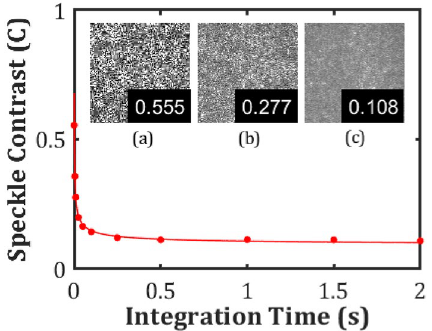
Figure 5. Speckle contrast measured after passing through a chiral nematic LC device (E7 + 4.7 wt% BDH1281, pitch 310 nm) under a square wave electric field of amplitude 13.6 Vµm −1 and a frequency of 75 Hz at a range of camera integration times. The cell thickness was d = 20 µm, cell temperature T = 25 °C. The data points were obtained from measurements and the solid red line is a fit of the form ax −0.5 + b which shows that C reduces approximately by 1 / √ τ . Inset speckle images shown for ( a ) 1 ms, C = 0.555, ( b ) 10 ms, C = 0.277, ( c ) 2 s, C = 0.108 integration time and speckle contrast values,